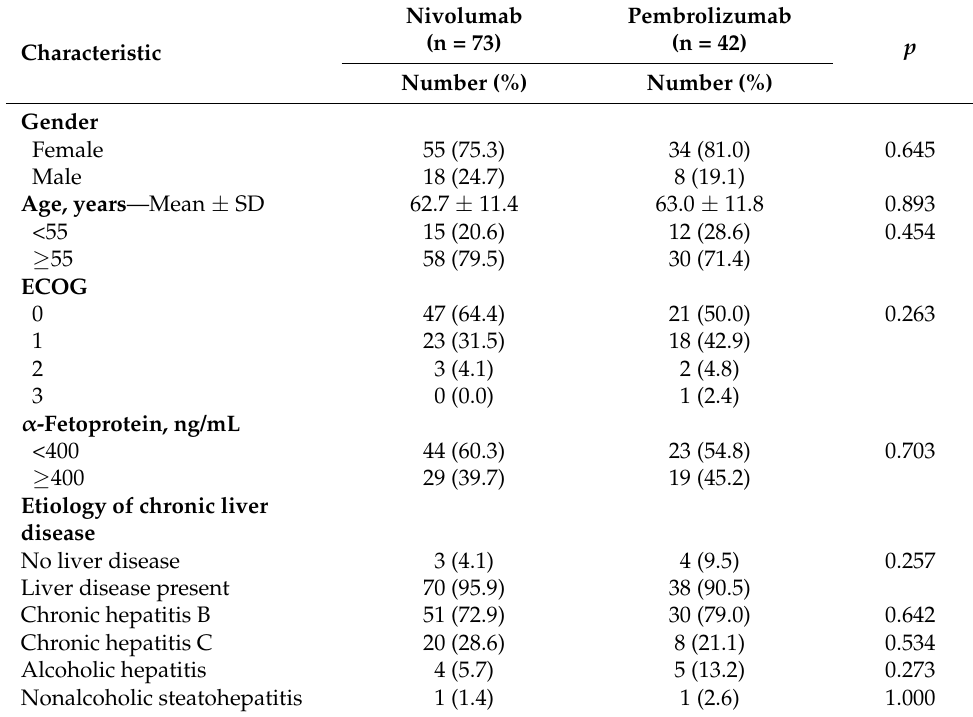
Table 1. Baseline characteristics of all